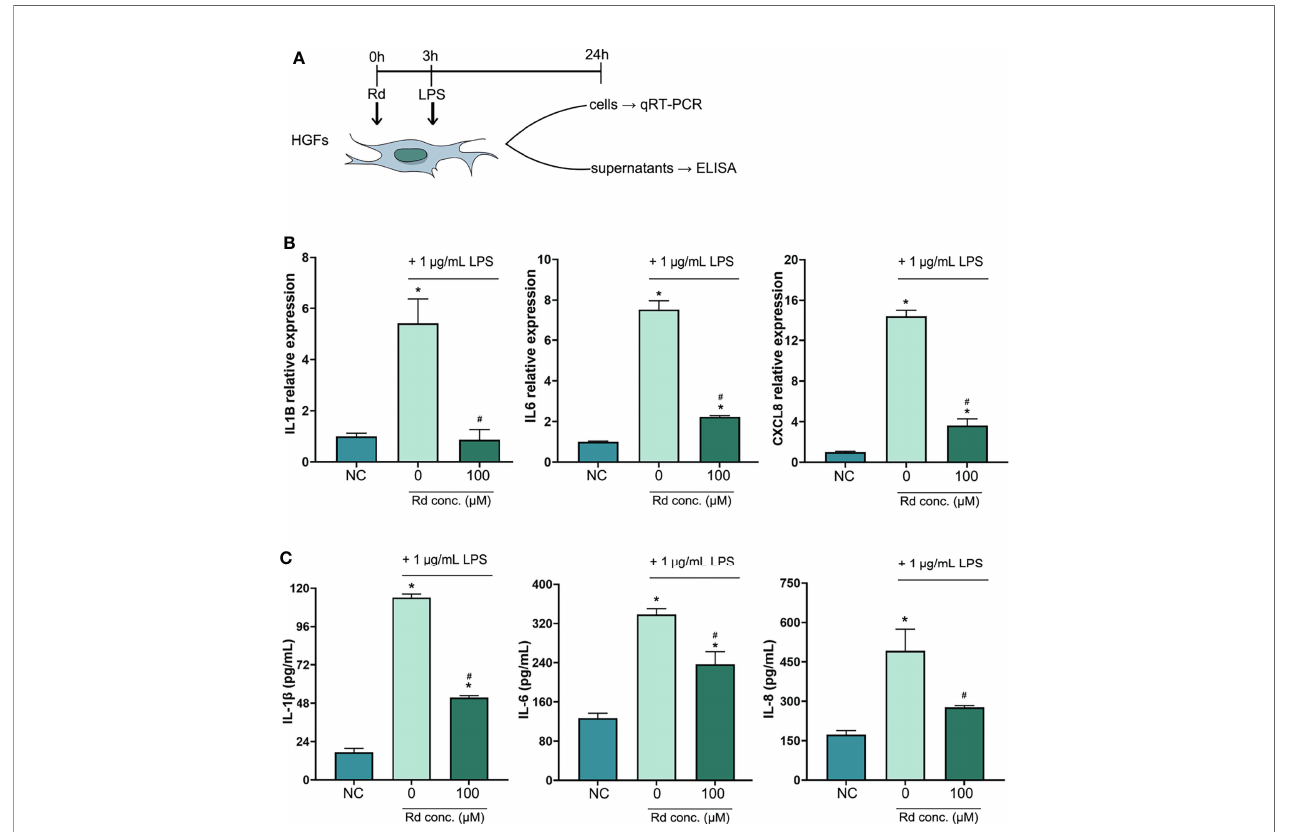
FIGURE 3 | Inhibitory effects of ginsenoside Rd on in fl ammatory responses in vitro . (A) The sketch of anti-in fl ammation experiments in vitro . (B) Expressions of IL1B , IL6 , and CXCL8 genes were normalized by the 2 − DD Ct method relative to the human ACTB reference gene. (C) Concentrations of secreted IL-1 b , IL-6, and IL-8 were determined by ELISA. The results are shown as mean ± SD ( n = 3). * p < 0.05 versus the normal control; # p < 0.05 versus the 0- m M